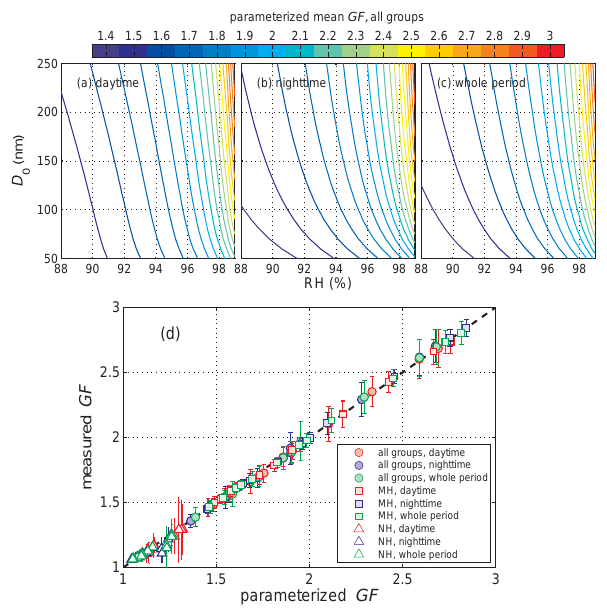
Fig. 8. Contours show the parameterized mean growth factors of all groups during (a) daytime; (b) nighttime; (c) whole period of HaChi summer campaign. (d) Comparison between measured and parameterized growth factors; the error bars represent the one stan- dard deviation of the measurements during the summer campaign period; the dashed line shows the 1:1 line.